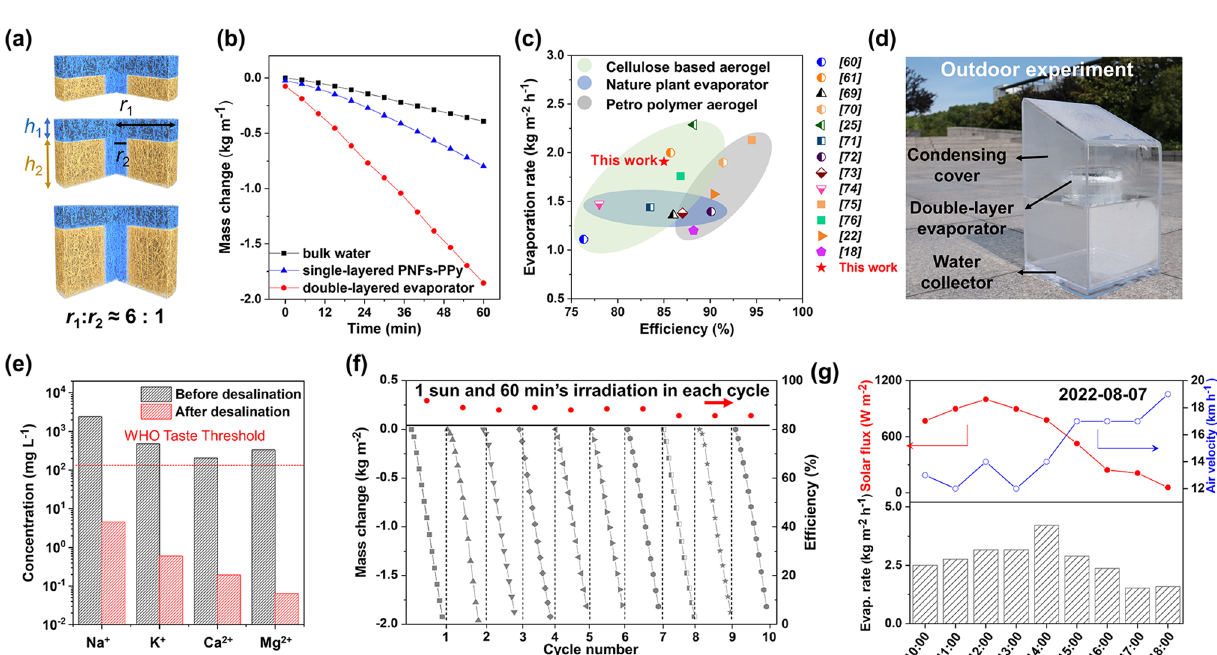
Fig. 6 High-performance solar-powered interfacial evaporation. a Schematic drawings of superposed double-layered evaporators, where blue area represents PNFs-PPy and yellow area represents VNFs. b Time-dependent mass change of bulk seawater, single-layered PNFs-PPy, and double-layered evaporator under 1 sun irradiation. c Comparison of evaporation rates and efficiencies showing high performance of our evapo- rator. d Photograph of the setup for solar-driven water collection. e Four primary ion concentrations of a simulated seawater before and after desalination. f A long-term stability measurement of our evaporator over 10 h. g Water evaporation rates during 8 h of outdoor solar desalination with monitoring of sunlight intensity and air